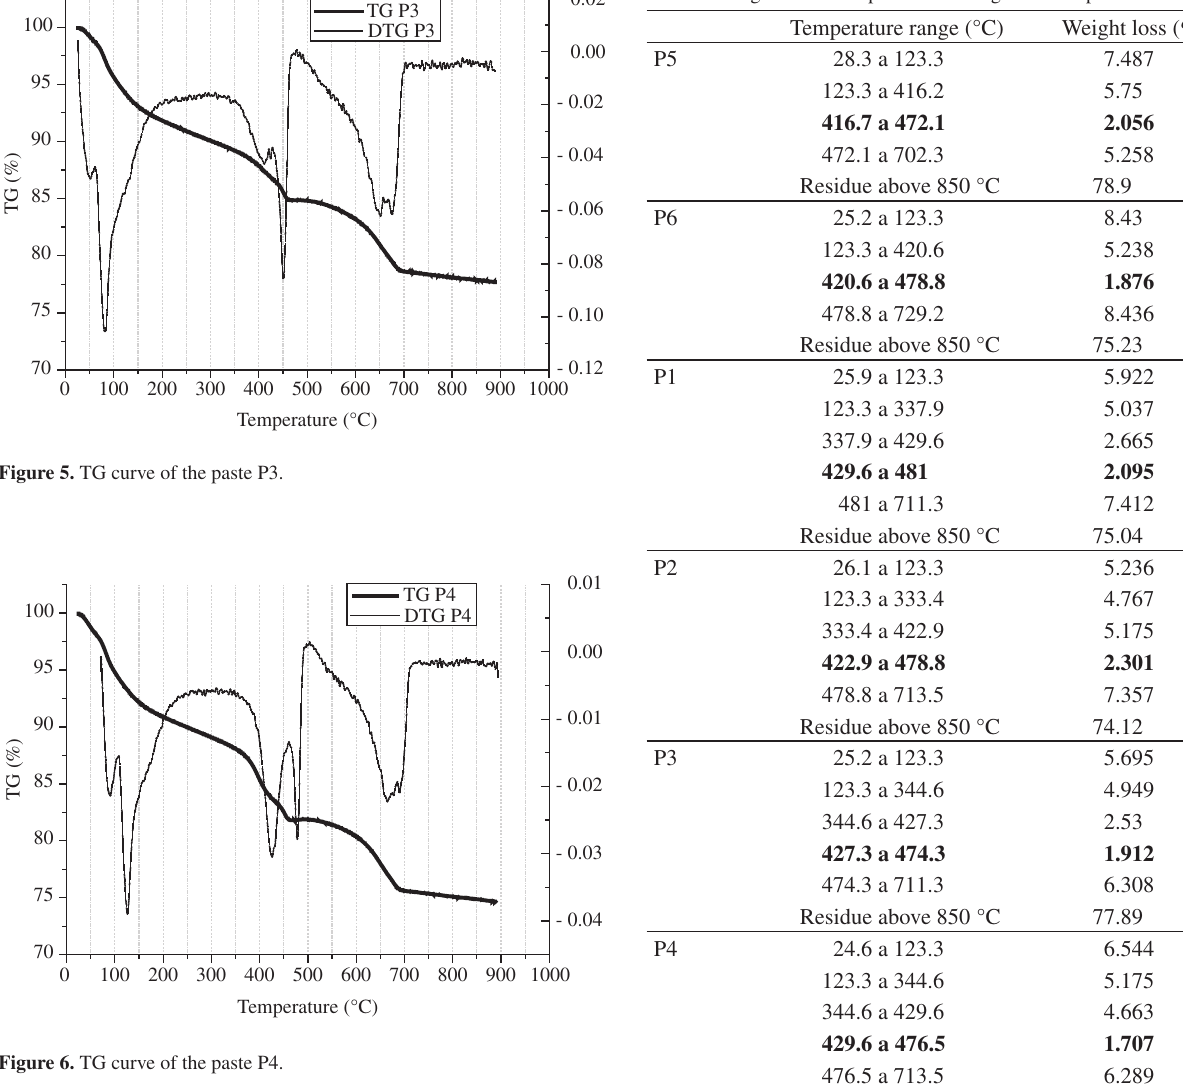
Table 5. Weight loss of the pastes according to the temperature.